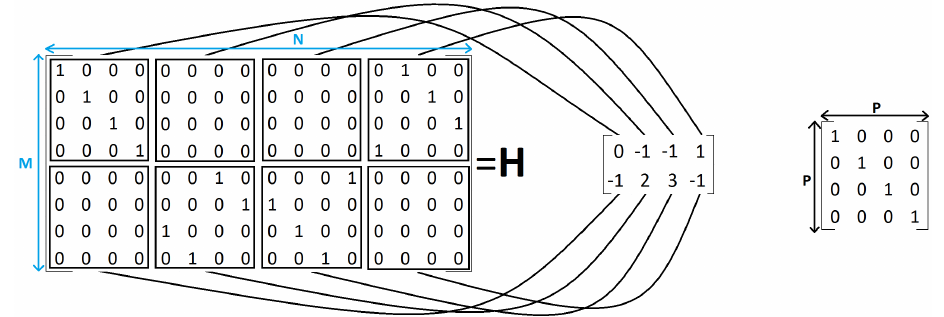
Figure 1. An example of a check matrix H of the Quasi-Cyclic Low-Density Parity-Check (QC-LDPC) code and simplified notation in the form of an offset matrix.